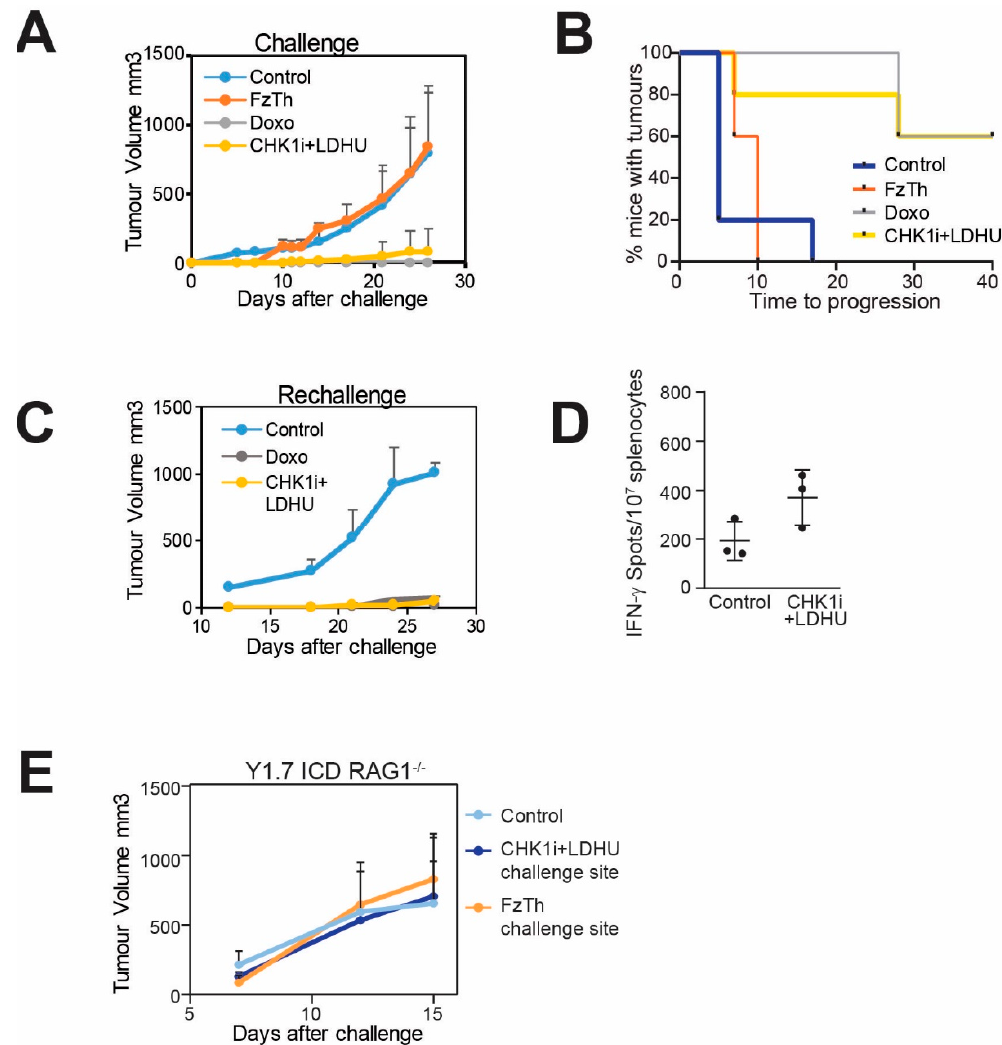
Figure 2. CHK1i+LDHU promotes ICD. ( A ). C57BL/6J mice were immunised with YUMMUV1.7 cells treated in vitro with either doxorubicin (Doxo) as a positive control for ICD or 0.2 mM SRA737+0.1 mM HU (CHK1i+LDHU) for 48 h. Freeze-thaw killed (FzTh) YUMMUV1.7 cells were used as a negative control for ICD. At 10 days after immunisation mice were rechallenged with live YUMMUV1.7 cells into the opposite flank and tumour growth followed. N = 5 mice each treatment. ( B ). Kaplan Meier graph of the same experiment as A, showing time to tumour progression of the rechallenge tumours. Progression was scored when tumours exceeded 50 mm 3 . ( C ). Additional control injected mice, and the mice that were protected by immunisation with either SRA737+LDHU or doxorubicin treated YUMMUV1.7 injected cells from A., were rechallenged with live YUMMUV1.7 cells 60 days after the original immunisation and tumour growth followed. ( D ). Splenocytes from either control or SRA737+LDHU treated YUMMUV1.7 immunised mice were challenged with 300cGy irradiated YUMMUV1.7 cells and an ELISpot assay of IFN γ was performed. ( E ). Rag1 − / − knockout mice were injected with the same cells as in panel A and tumour growth followed at the challenge site.